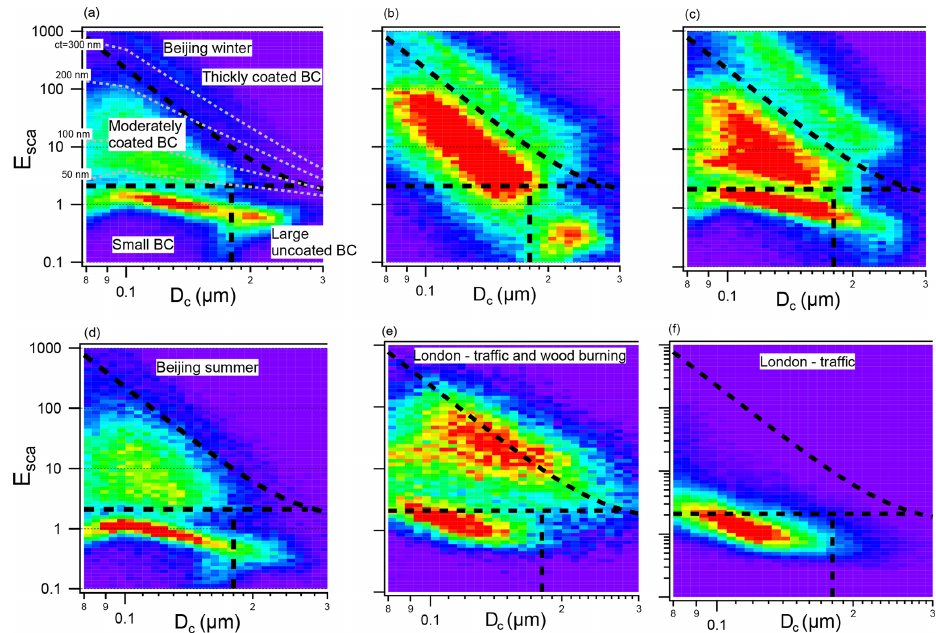
Figure 9. Scattering enhancement ( E sca ) as a function of BC core size ( D c ) for the three periods (as period I–III indicated in Fig. 3) in Beijing winter (a–c) , Beijing summer (d) , London with mixed sources (e) , and London with traffic source (f) . Each plot is coloured by particle number density (the colour scale is set to be red when the number density is above 70% of the maxima in each panel). The particles are separated as four groups using the borders (from top to bottom) at y = 3 . 38 + 0 . 000436 ∗× ˆ− 5 . 7, y = 2 . 1, x = 0 . 18, as shown by dashed lines on each plot. The dashed grey lines on (a) denote coating thicknesses mapped on the E sca − D c